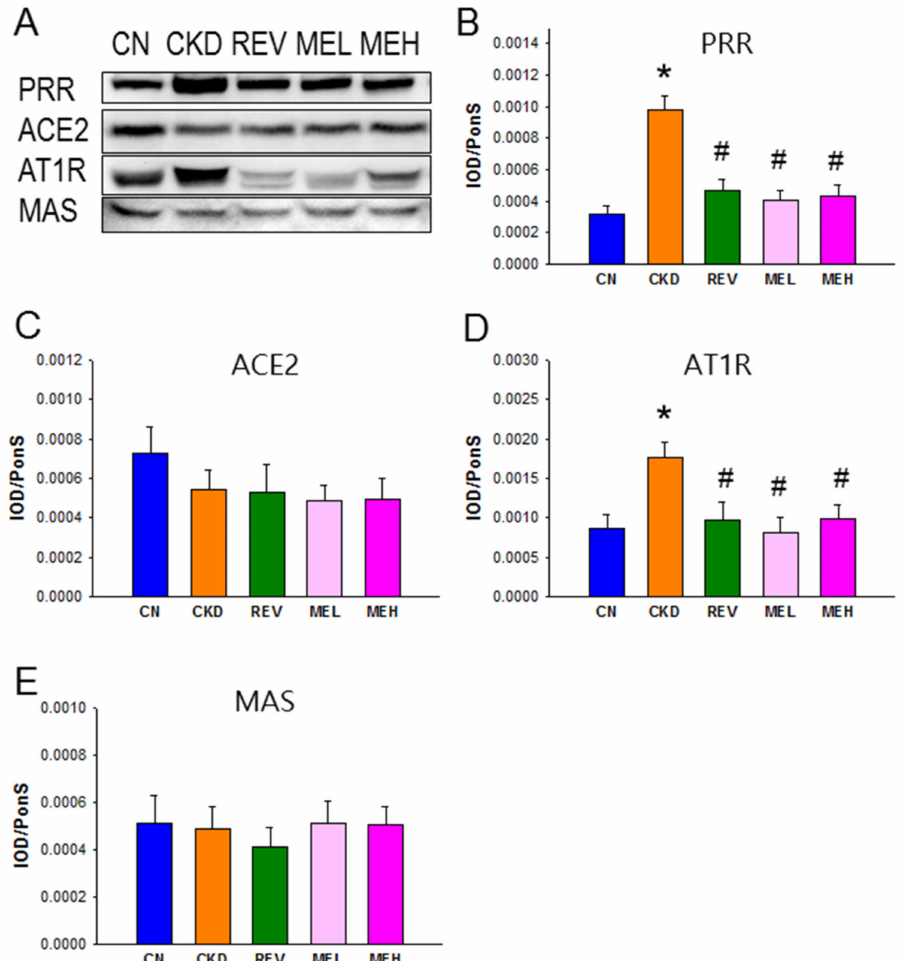
Figure 3. Protein expression of the renin–angiotensin (RAS) system components in rats at 12 weeks of age. ( A ) Representative Western blots showed (pro)renin receptor (PRR, 39 kDa), angiotensin- converting enzyme 2 (ACE2, 90 kDa), angiotensin II type 1 receptor (AT1R, 43 kDa), and angiotensin (1–7) receptor MAS (37 kDa) bands. Relative abundance of renal cortical ( B ) PRR, ( C ) ACE2, ( D ) AT1R, and ( E ) MAS, as quantified. n = 8/group; * p < 0.05 vs. CN; and # p < 0.05 vs.